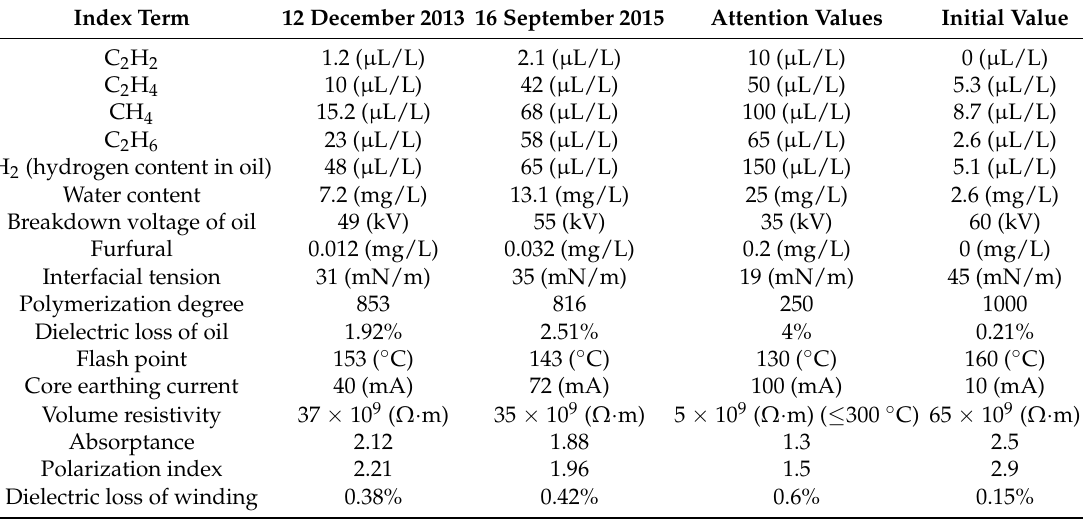
Table 3. Preventive test data of the transformer.